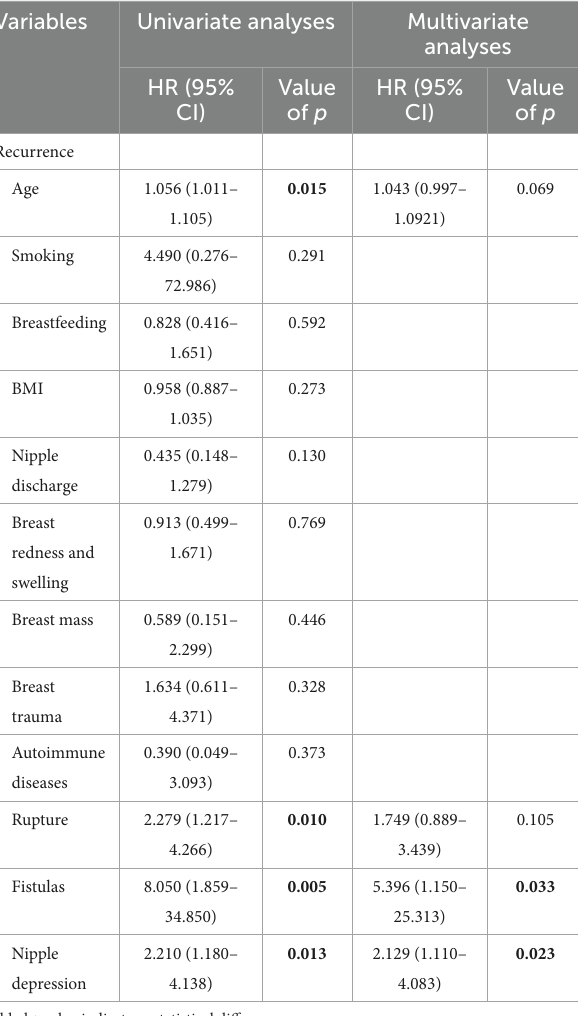
Bolded p value indicates a statistical